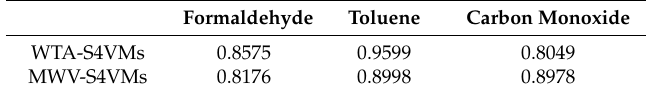
Table 6. Outcome of WTA-S4VMs and MWV-S4VMs in multi-gases.